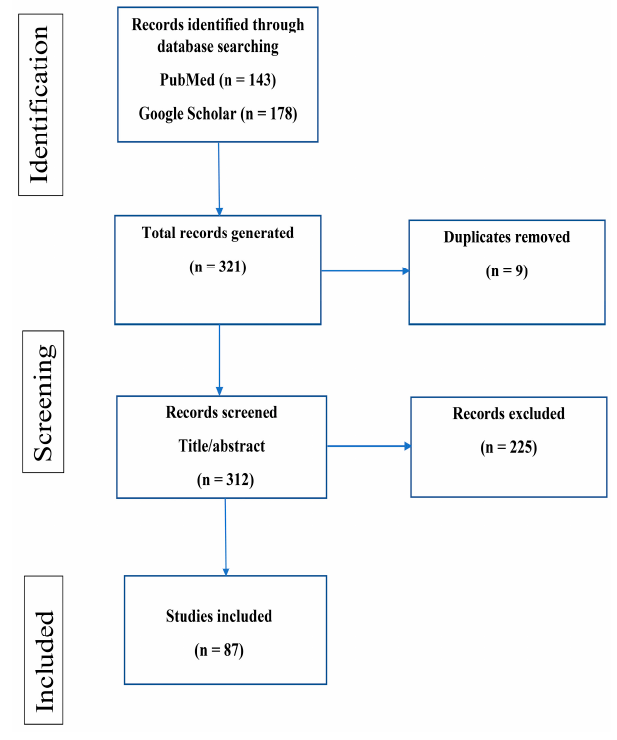
Figure 1. Flow diagram of scoping review selection